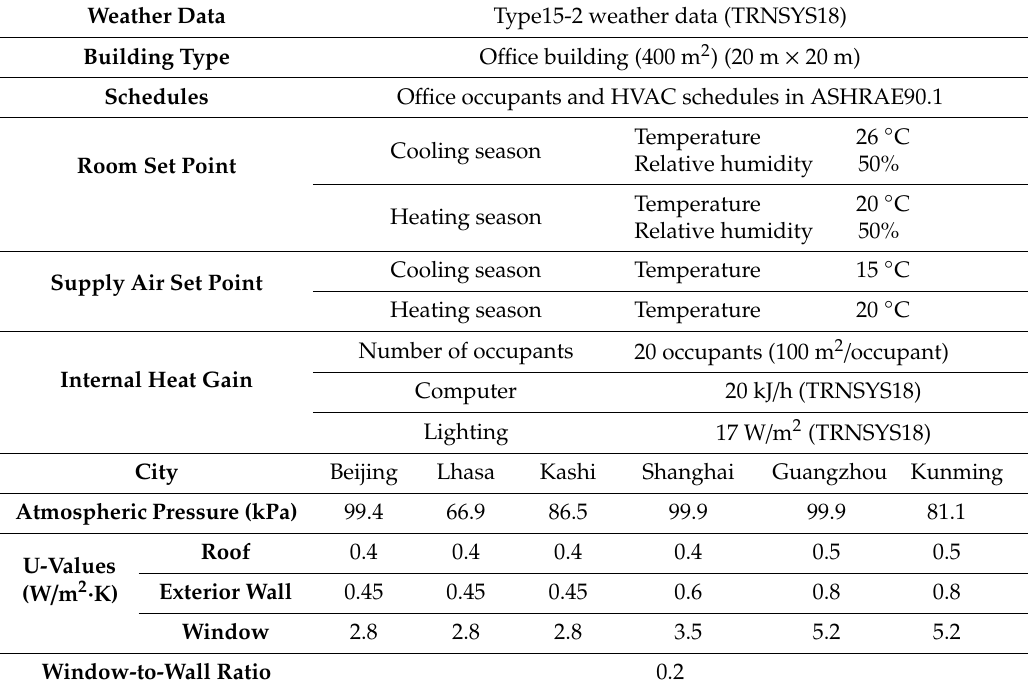
Table 1. Physical information of the model buildings studied